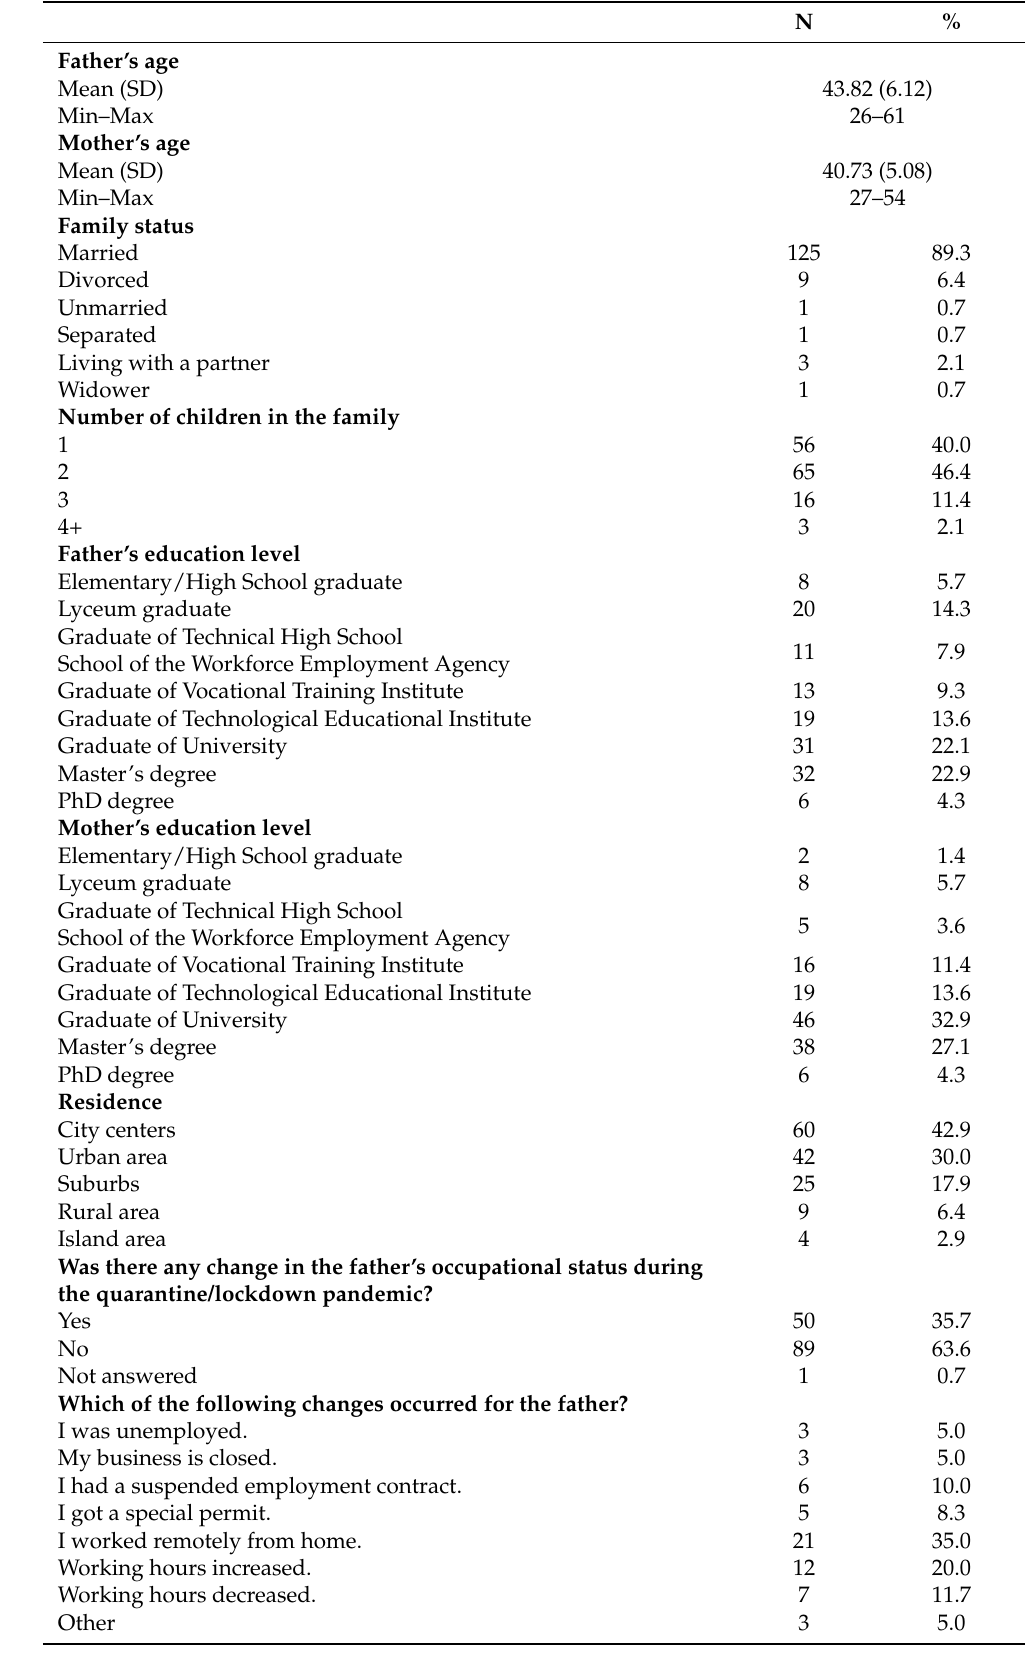
Table 1. Demographic